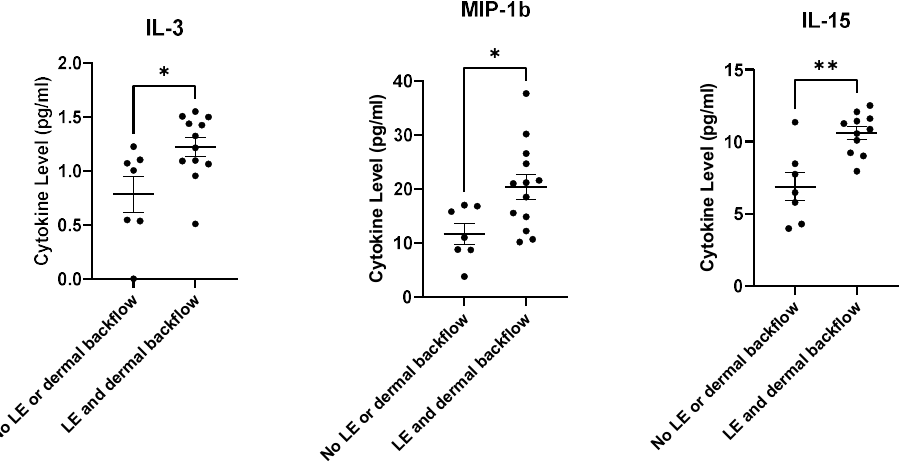
kine/chemokine levels did not reach significance, but many trended upwards (Figure S5).